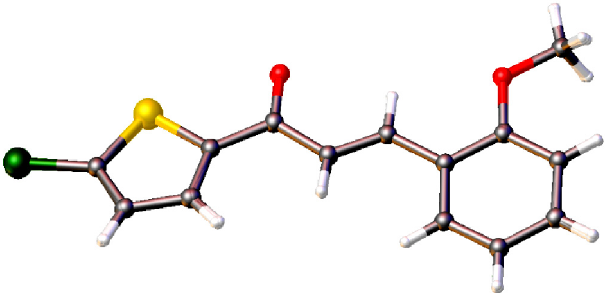
Figure 6. Overlay of all atoms in compound 4d , comprising four independent molecules.